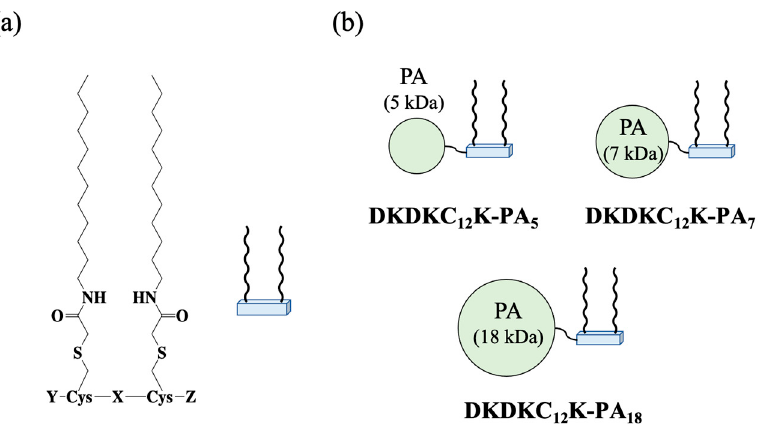
Figure 1. Chemical structure of PG-surfactants and schematic illustration of their conjugates with polyacrylamide (PA) ( a ) Chemical structure of PG-surfactants with C 12 alkyl chains (X: linker peptide, Y, Z: peripheral peptide). ( b ) Schematic illustration of the PA-appended solubilization surfactants, DKDKC 12 K-PA n ( n = 5, 7, and 18). X is -Asp-Lys-Asp-Lys and Z is -NH 2 . Y is Ac-Cys-Lys-, in which PA unit was covalently connected to side chain of Cys via S-S